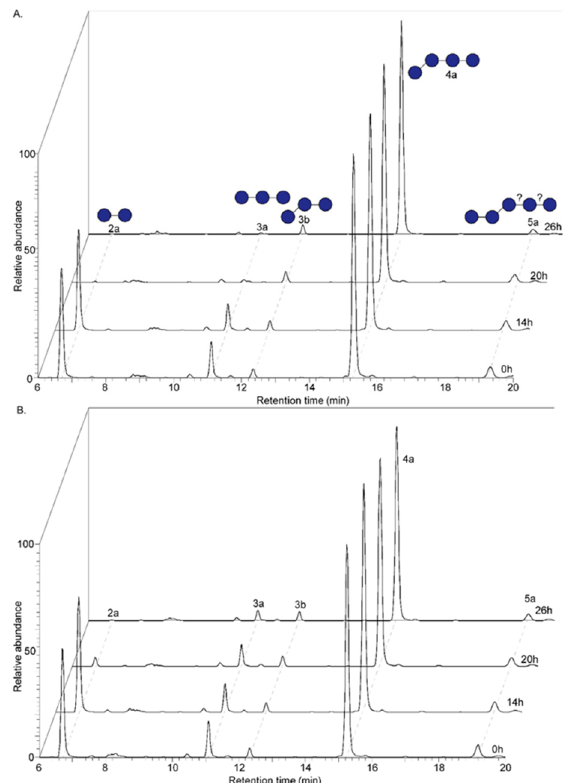
Figure 2. UHPLC ‐ PGC ‐ MS profiles of enzyme ‐ treated oat β‐ glucan (eOBG) at the start and after 14, 20 and 26 h of fermentation using pooled fecal inoculum of 2 ‐ ( A ) and 8 ‐ ( B ) week ‐ old infants. Peaks are labelled with 1a: 1 = degree of polymerization, a = letter qualifier. Corresponding structures are placed above label with —: β (1–4) ‐ linkage and /: β (1–3) ‐ linkage.